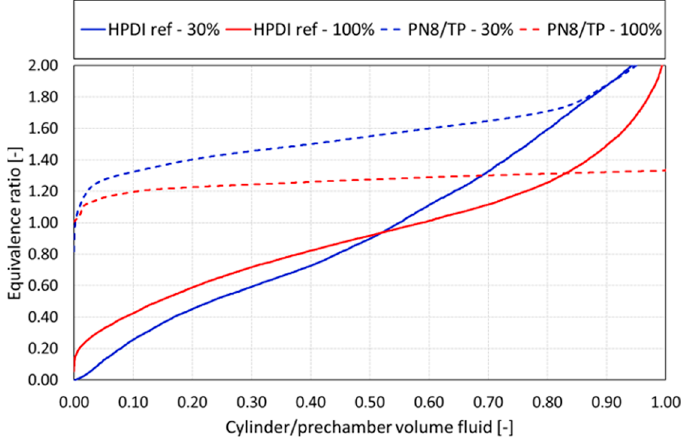
Figure 25. Fuel homogenization for the 7500 rpm cases: comparison between the PN8 prechamber with TP injection (dashed lines) and the same engine in the standard configuration equipped with the high-pressure direct injection (HPDI) system (continuous lines).